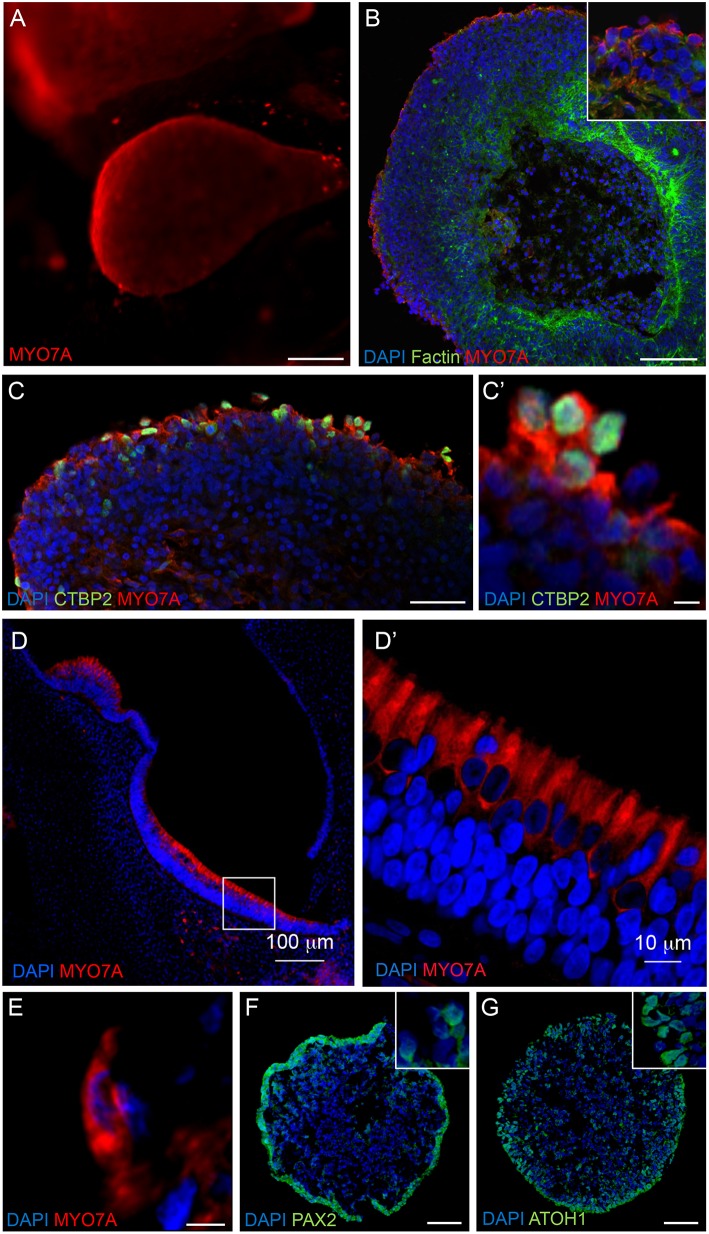
Expression of hair cell and otic placode markers in RCCS-derived organoids. (A) HESC-derived organoids show MYO7A+ protrusions on surface at 56 DIV. (B,C) cells in the outer epithelium of vesicles expressing MYO7A and f-ACTIN (B) as well as CTBP2 (C,C') at 35 DIV. (D–E) Human fetal saccule at 11 WG consists of hair cells expressing MYO7A (D) which defines the typical cylindrical shape of type II hair cells (D') and similarly detected within organoid at 35 DIV (E). (F,G) Expression of PAX2 (F) and ATOH1 (G) in occasional otic-pit-like clusters of cells in the outer epithelium of hiPSC-derived organoid at 7 DIV. Scale bars, (A) 200 μm, (B,D) 100 μm, (C,F,G) 50 μm, (D') 10 μm, (C',E) 5 μm.